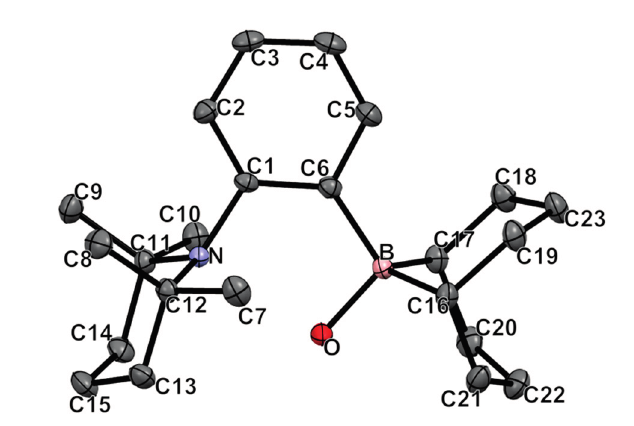
Figure 2. ORTEP diagram of compound 2 . Thermal ellipsoids are drawn at 50% probability. Hydrogen atoms are omitted for clarity. Selected bond lengths (Å) and angles (deg): B-O = 1.539(2); B-C6 = 1.666(2); N-C1 = 1.490(2); B-N = 3.121(2); C6-B-C16 = 114.9(1); C6-B-C17 = 114.9(1); C6-B-O = 105.3(1); C16-B-C17 = 104.2(1); C12-N-C11 = 118.3(1); C12-N-C1 = 114.1(1); C11-N-C1 = 116.1(1); N-C1-C6 = 118.3(1); B-C6-C1 =